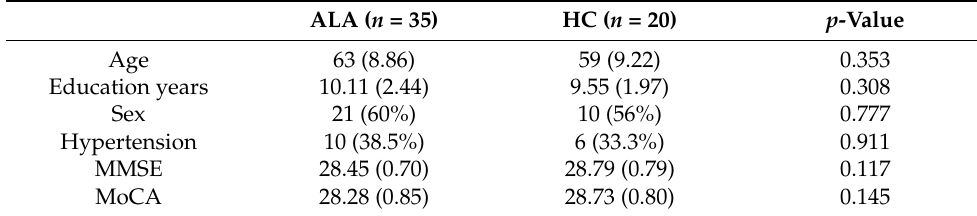
Table 1. Demographic data of